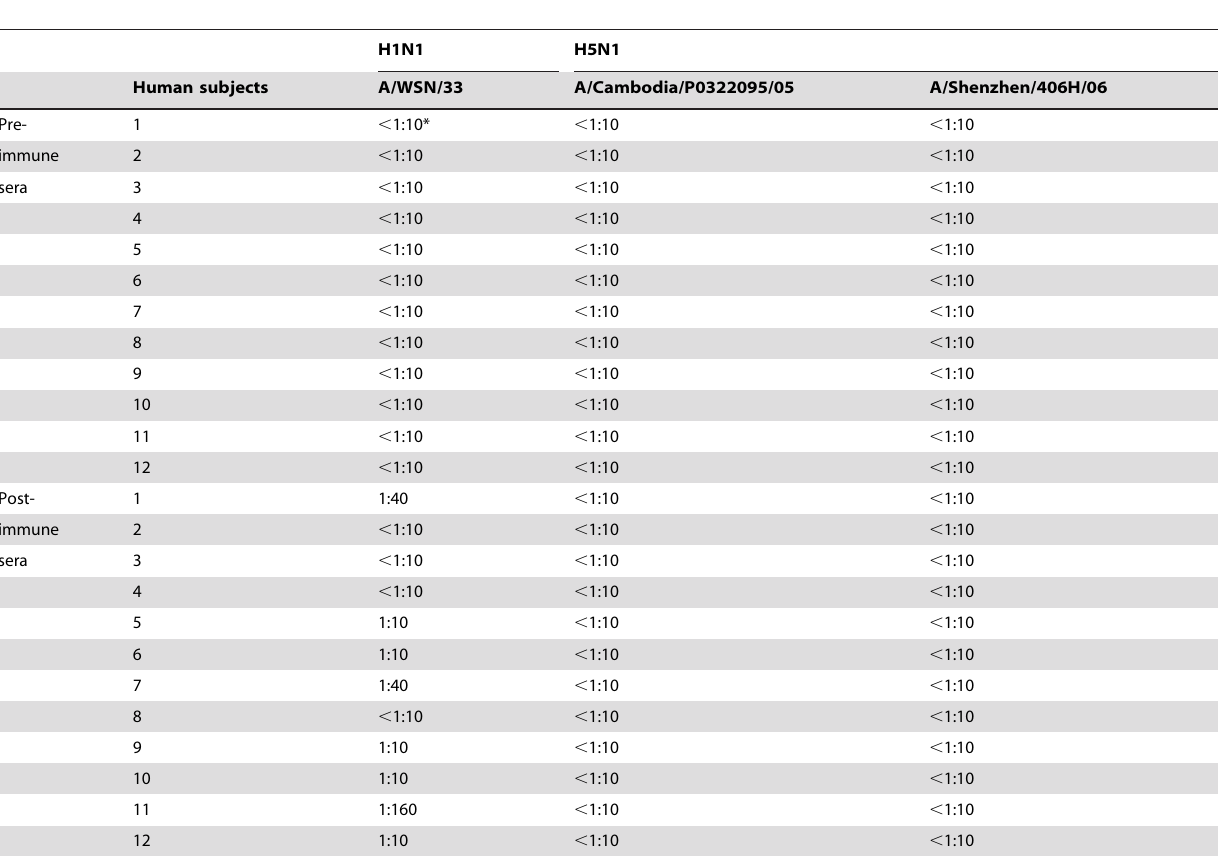
Table 3. Neutralizing antibody titers in pre- and post-immune sera measured by MN assay.